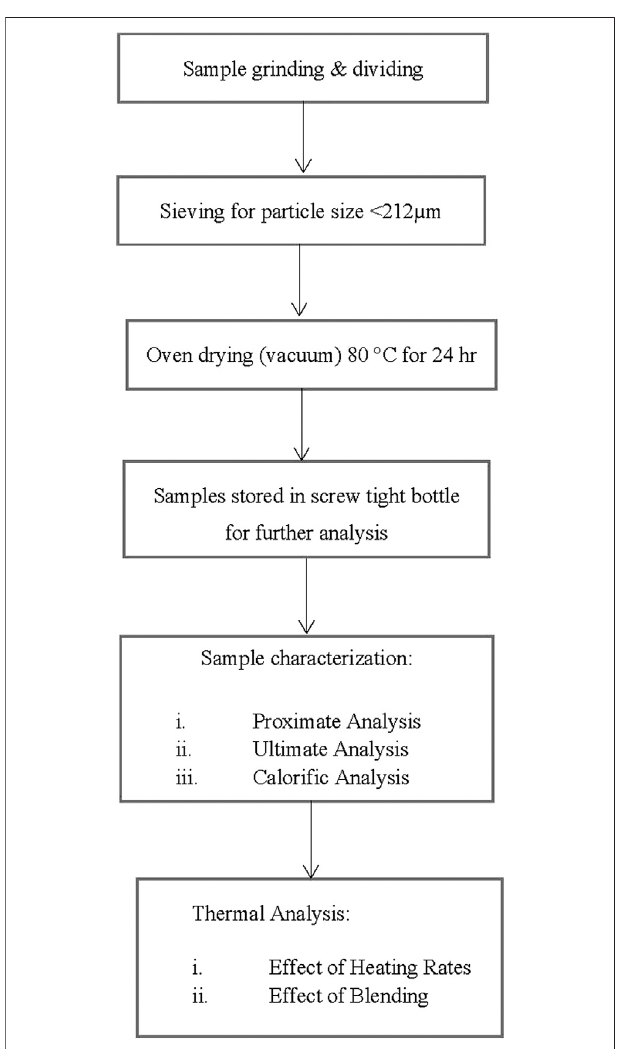
FIGURE 1 | Flow diagram for research